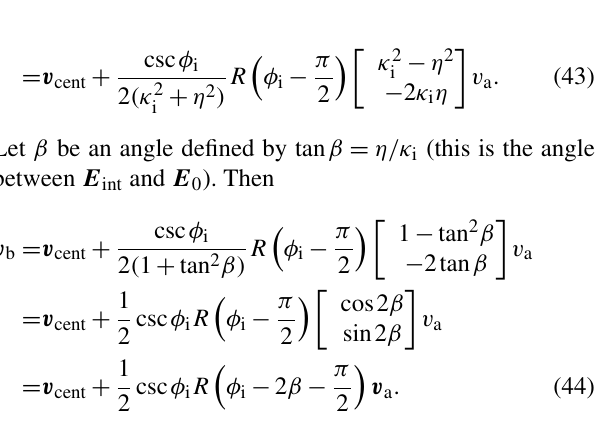
Figure 6. The construction of the circular arc (blue dotted curve) along which the drift of the boundary of a circular patch ( v b ) can occur for a given ion magnetisation κ i . The blue text shows the vari- ation of the drift along the arc for various values of the relative den- sity n , which determines the angle β . In this example κ i ∼ 1 . 5.